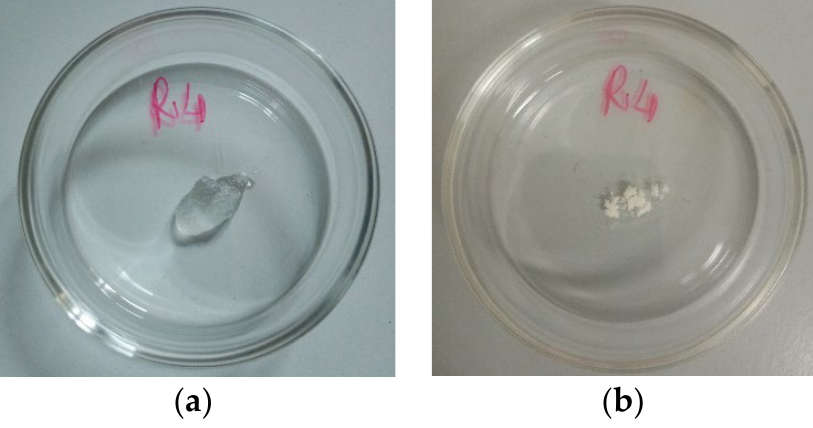
Figure 6. Appearance of SR4 at time t 0 ( a ) and appearance of DR4 (time t 7 ) ( b ). As observable in Figure 6, when heat-dried, R4 leaves a porous amorphous solid. Table S1 in Supplementary Materials shows the data of the experiments, including the weights of R4 determined at times T 0 –T 7 and the related cumulative weight loss percentages while Figure 7a shows the cumulative weight loss percentage curve of SR4 over time and gentle heating. Figure 7b shows, in the same color, the Higuchi kinetic model, which is the mathematical model that best fit the data of the cumulative weight loss curve in Figure